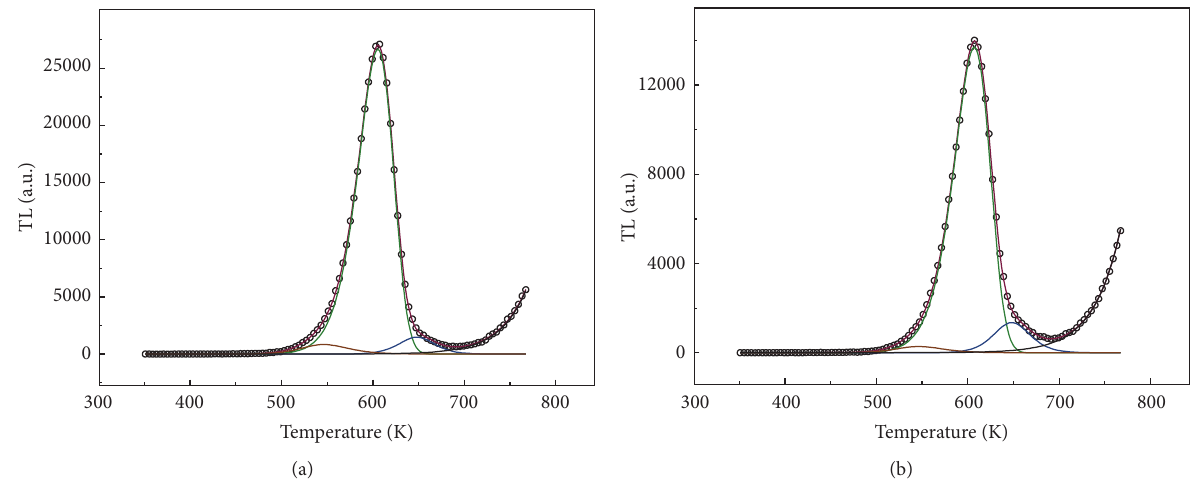
Figure 10: Examples of glow curve deconvolution (GCD) of CaSO 4 :Eu glow curve, as obtained after partial thermal cleaning up to (a) 543 K and (b) 593